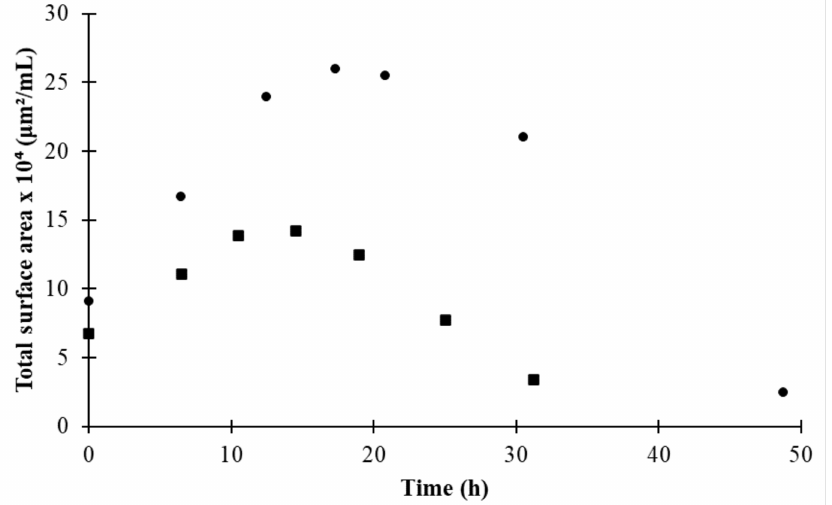
Figure 9. Total surface area of yeast in suspension per milliliter with respect to fermentation time. Data are presented as follows: average total surface area of suspended yeast per milliliter at 30 ◦ C (circles) and 35 ◦ C (squares).